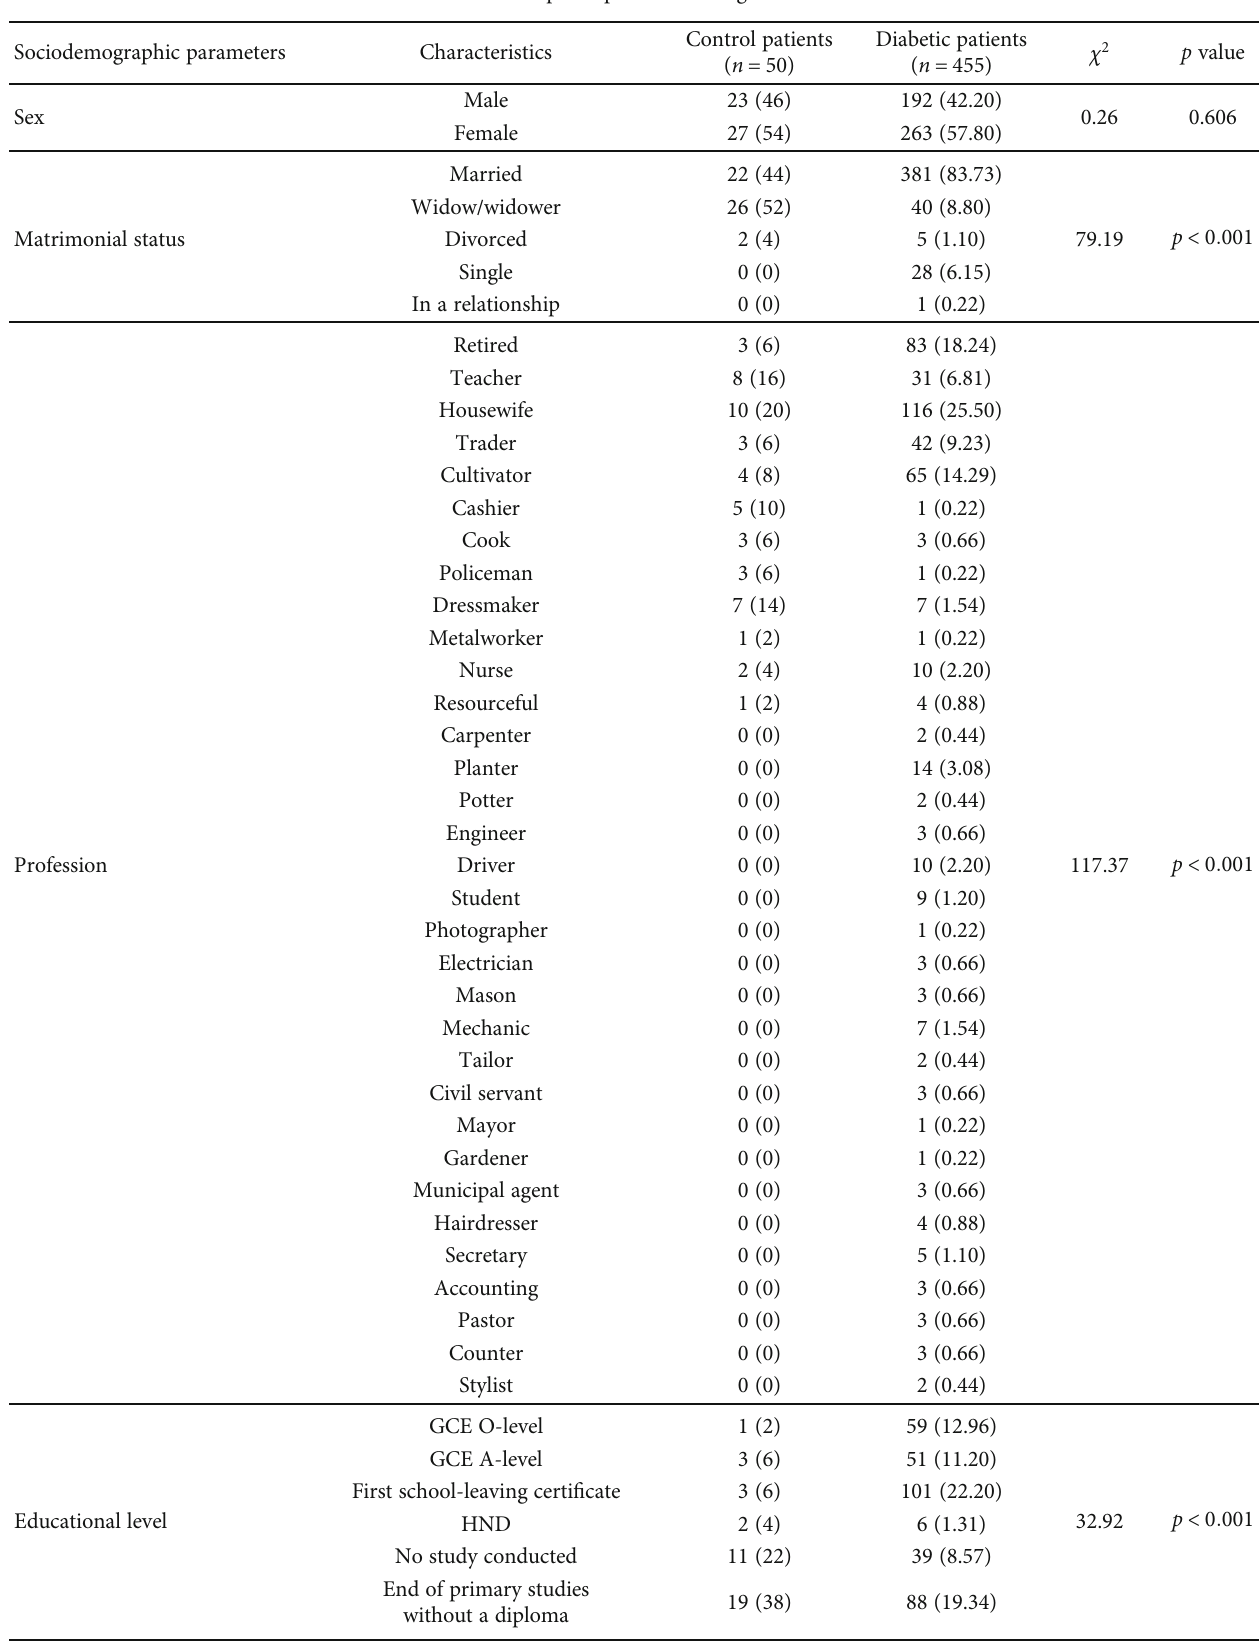
Table 2: Features of participants according to diabetes